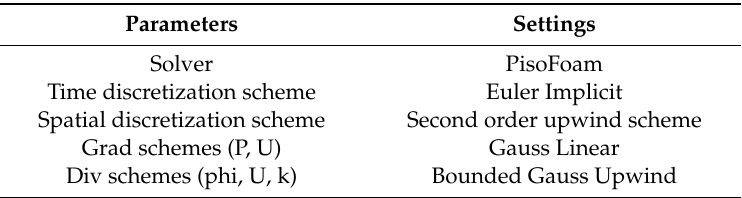
Table 3. Transient solution settings.